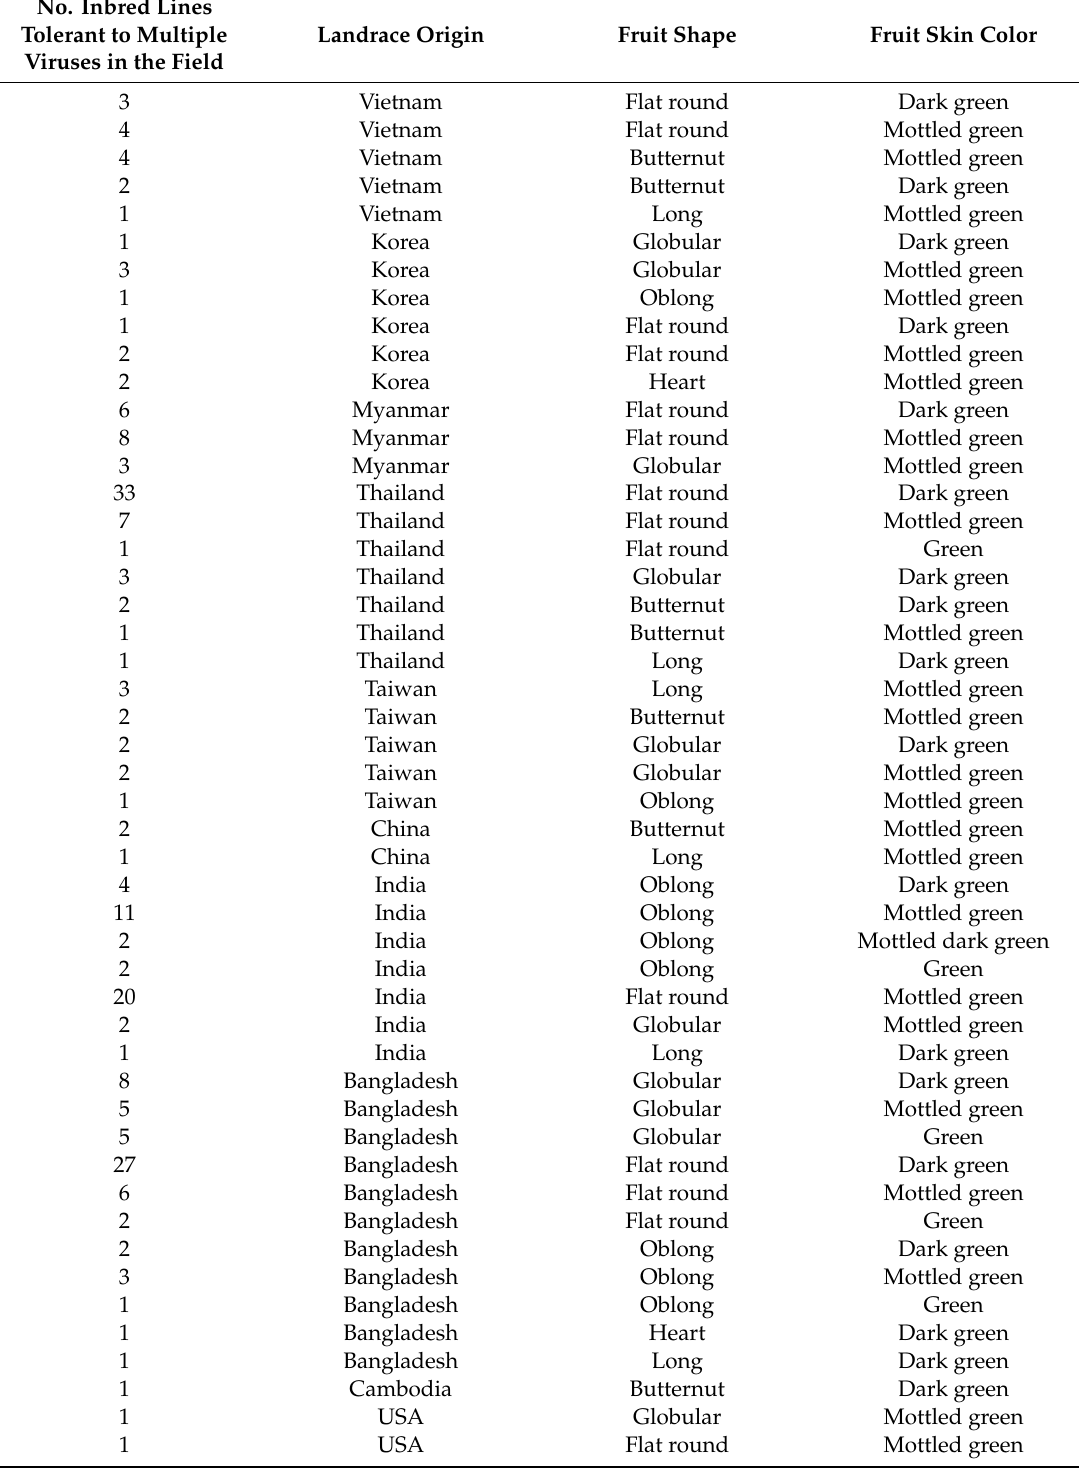
Table 3. Pumpkin lines of di ff erent market segments tolerant to multiple viruses developed from diverse germplasm accessions evaluated at the World Vegetable Center East and Southeast Asia, Thailand. No. Inbred Lines Tolerant to